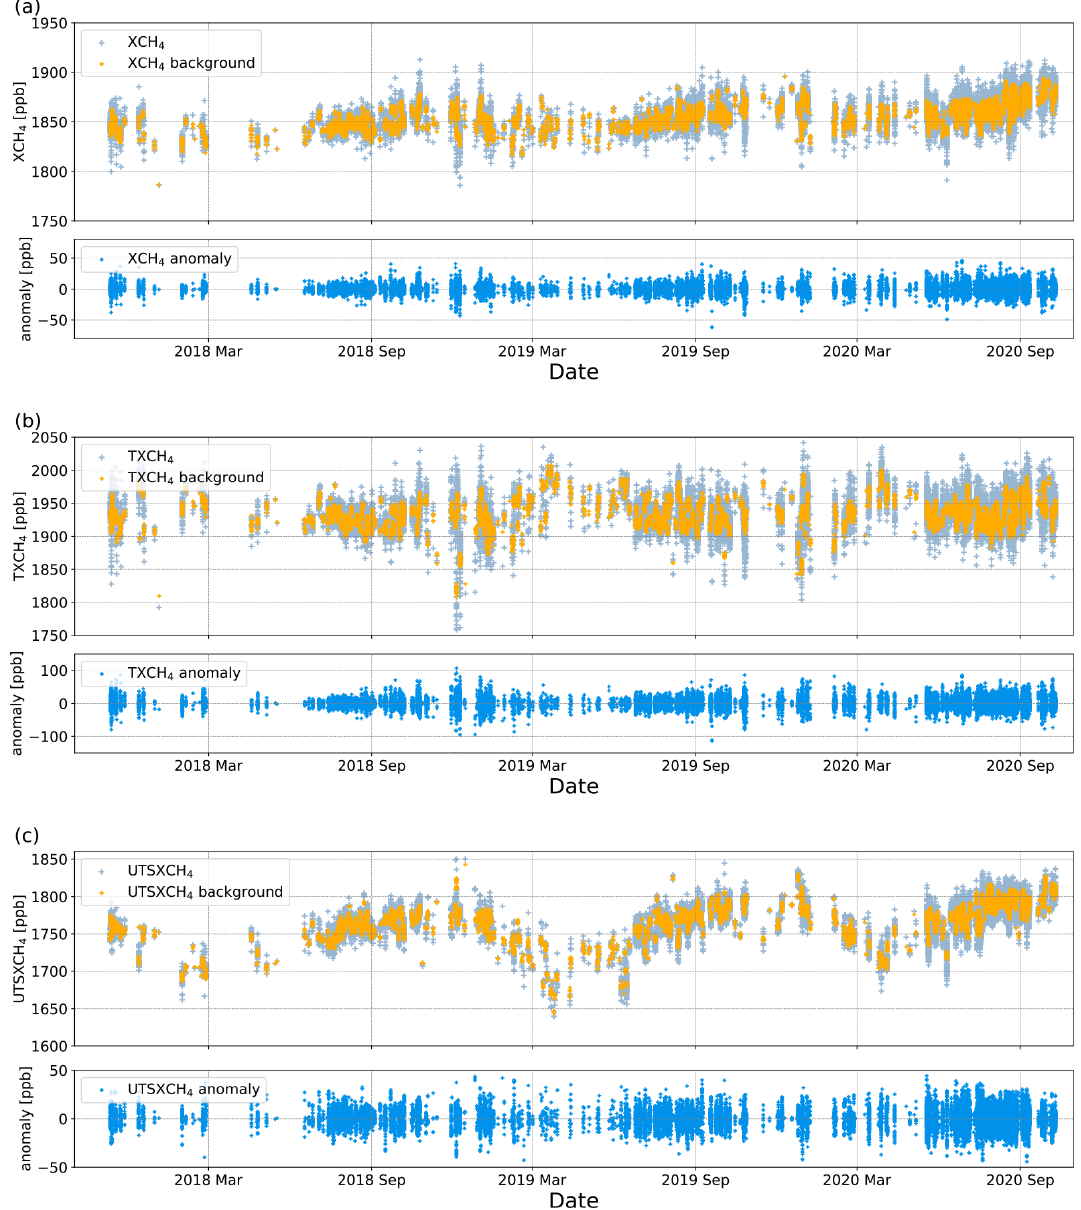
Figure 7. Time series of (a) XCH 4 , (b) TXCH 4 and (c) UTSXCH 4 , showing raw data and background in each upper panel and anomalies in each corresponding lower